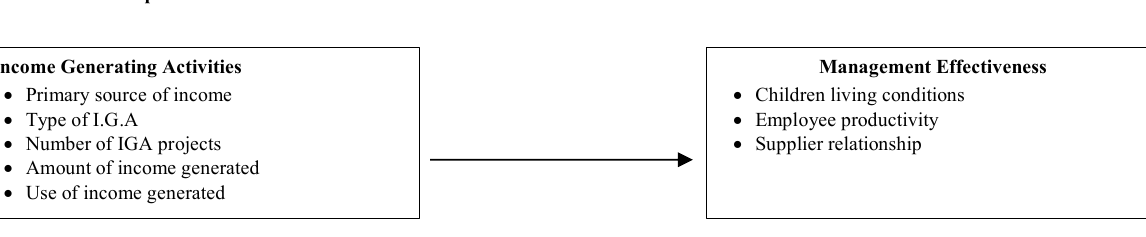
Figure 1: Influence of income generating activities on effective management of charitable children